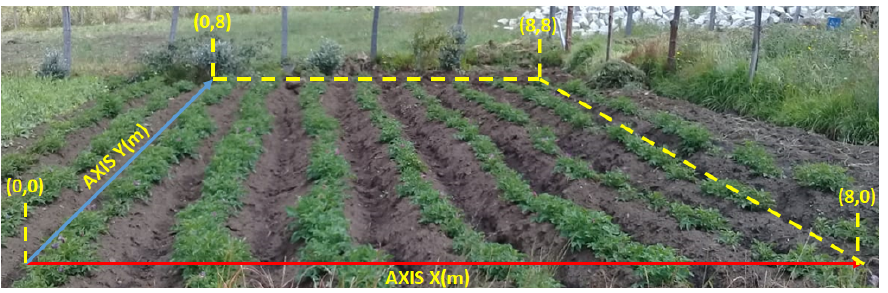
Figure 2. Small experimental plot with potatoes (8 m × 8 m), Solanum Phureja variety, 60 days after